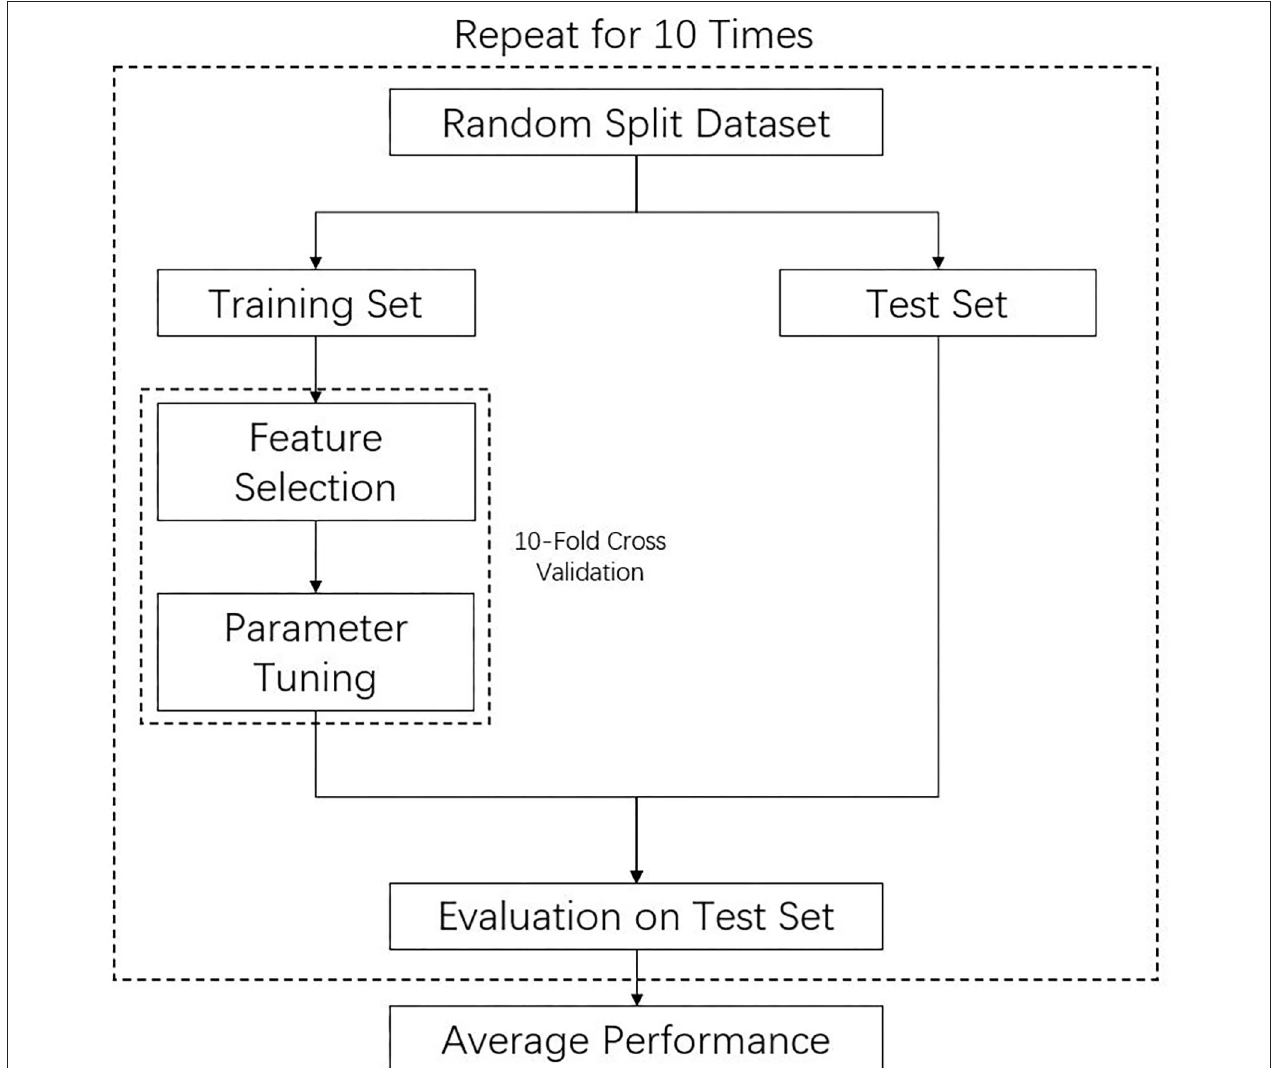
FIGURE 1 | Training and evaluation procedures of machine learning